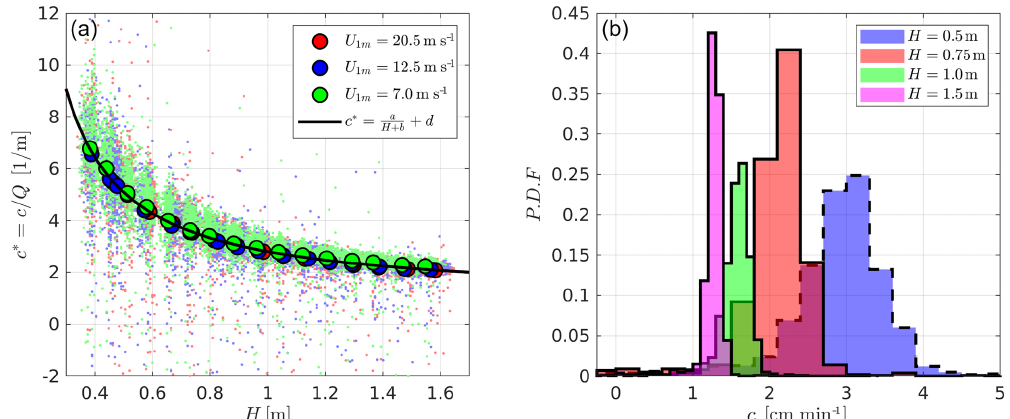
Figure 5. (a) Dune speed normalized by snow flux (c/Q) as a function of height (H) for all the solitary dune simulations performed. Note that the instantaneous speeds are presented by small lightly coloured symbols. Time-averaged dune speeds for each simulation are shown by large symbols. Note that all symbols are coloured according to the wind speed of the simulation. (b) Probability distribution function of dune speeds for barchans of four different